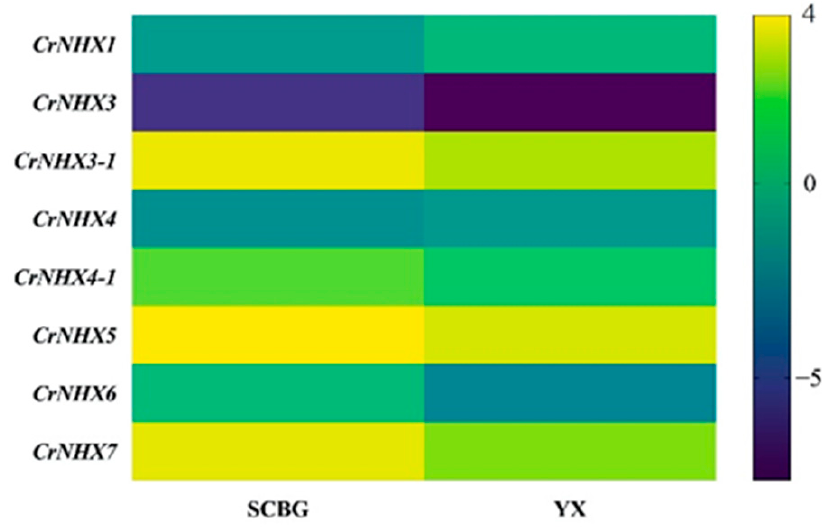
Figure 6. The expression differences of the eight CrNHXs in mature C. rosea leaves planted in the South China Botanical Garden (SCBG) and in Yongxing (YX) Island. Expression levels for each CrNHX were shown with the log2 values of FPKM. Yellow denotes high expression levels, and dark-blue denotes low expression levels.